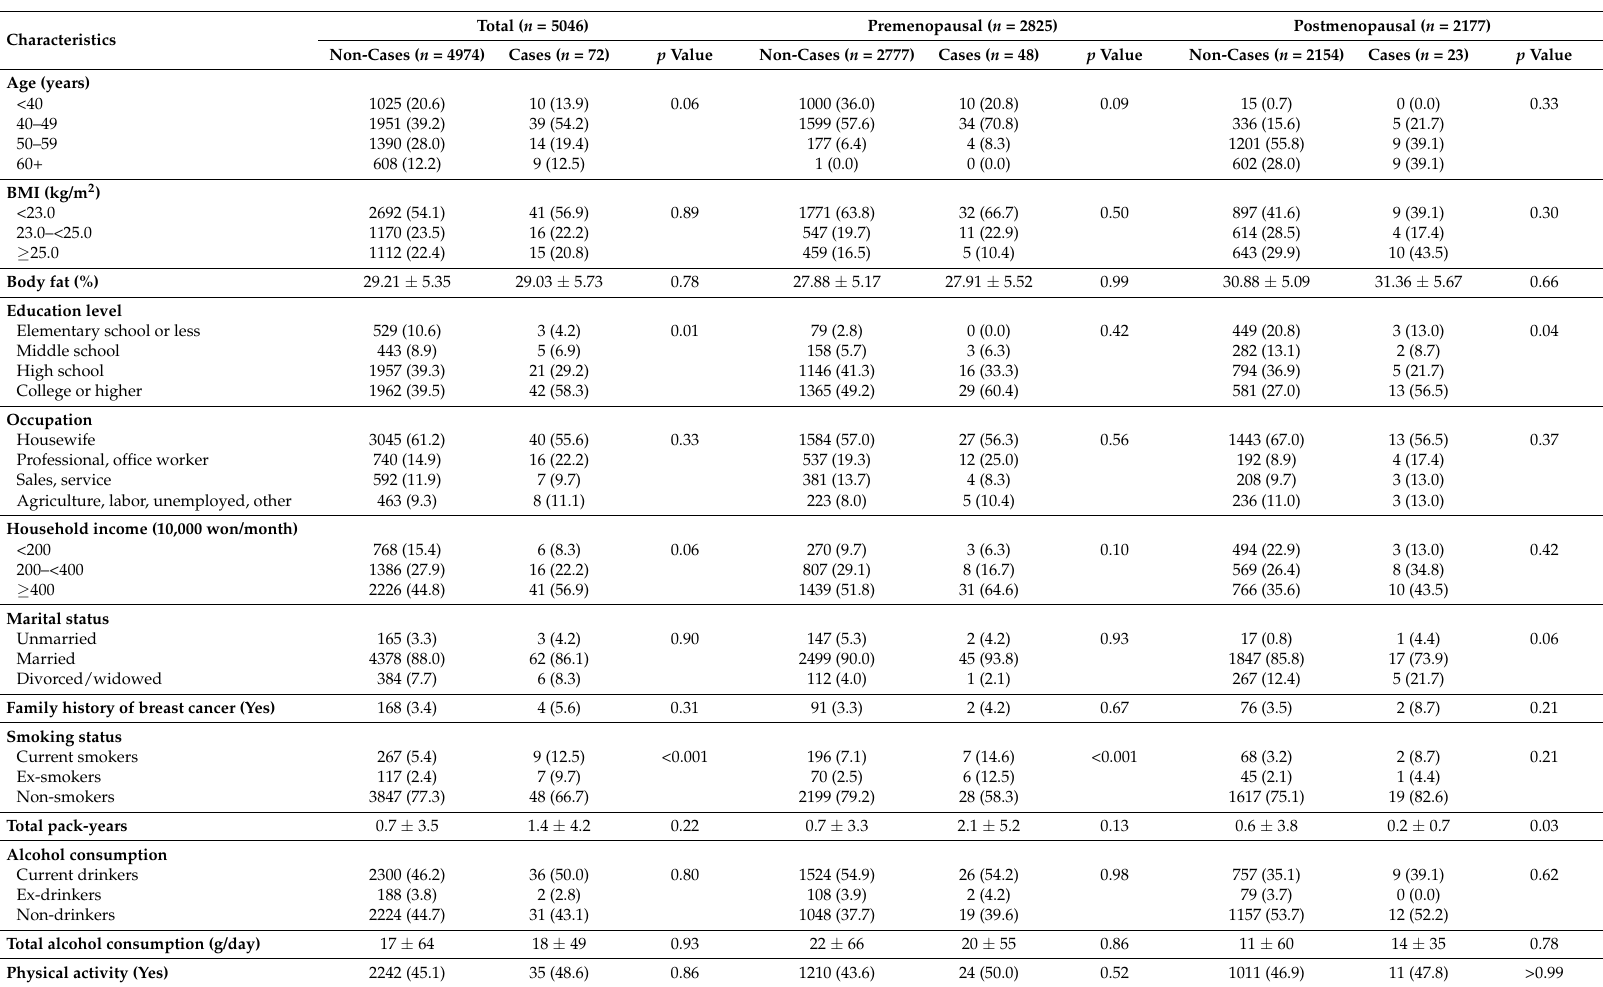
Table 1. General characteristics of the study subjects a